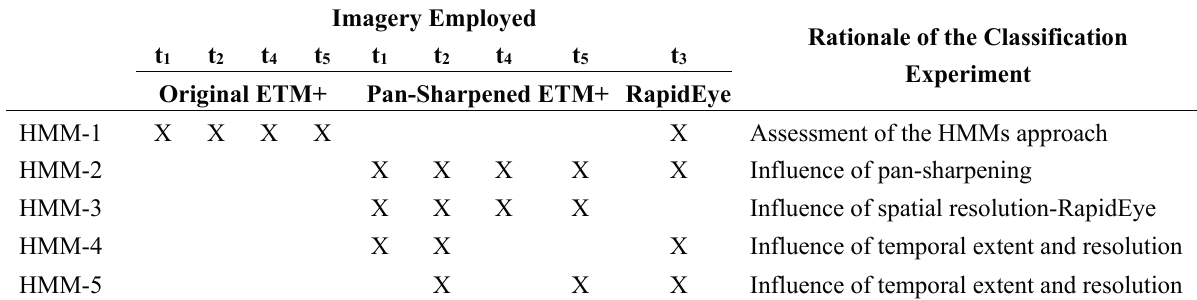
Table 2. Selections of different images included in the evaluation of our proposed